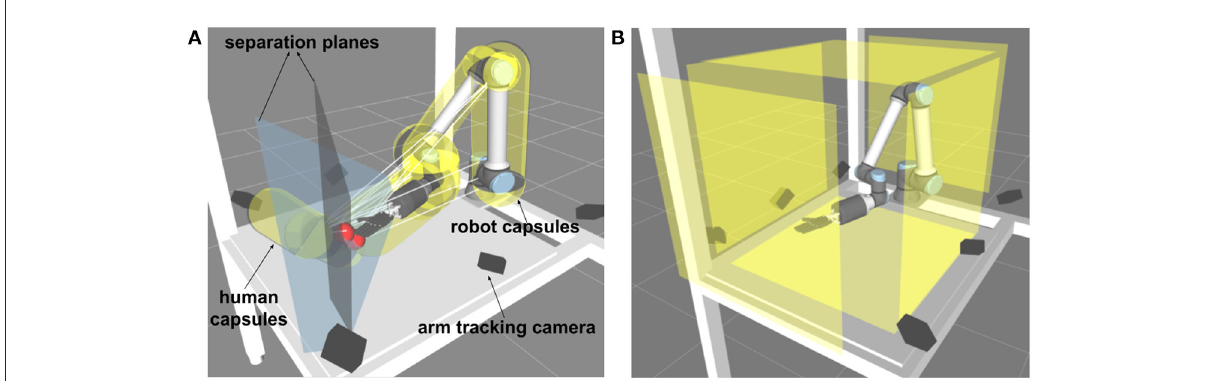
FIGURE3 Geometric model of the work cell. In this view, the human stands on the left side of the table with only the right arm reaching into the shared workspace. (A) We use capsules (yellow) as geometric primitives for each part of the robot and the operator arm (palm, wrist, lower arm, upper arm). Trajectory planning and collision avoidance were based on the pairwise human-robot capsule distances, which can be calculated efficiently. Also shown are two separating planes (blue) with their origins (red) on the midpoint between the two closest pairs (human-hand and -palm vs. robot palm) of capsules. (B) Static boundaries of the robot workspace; no part of the robot was allowed outside of the cuboid defined by the six planes.